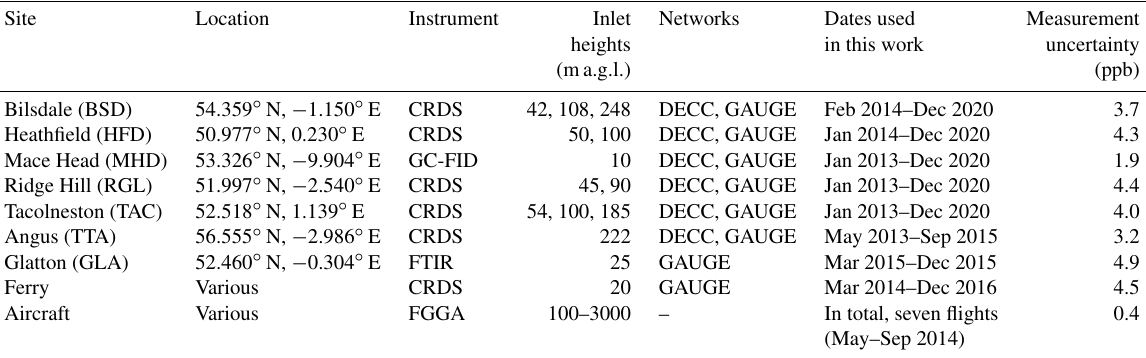
Table 1. Location, inlets, instruments, network definitions, sampling dates and observational uncertainties of each measurement site. Note: ppb – parts per billion; CRDS – cavity ring-down spectroscopy; FGGA – fast greenhouse gas analyser; FTIR – Fourier transform infrared; GC-FID – gas chromatograph and flame ionization